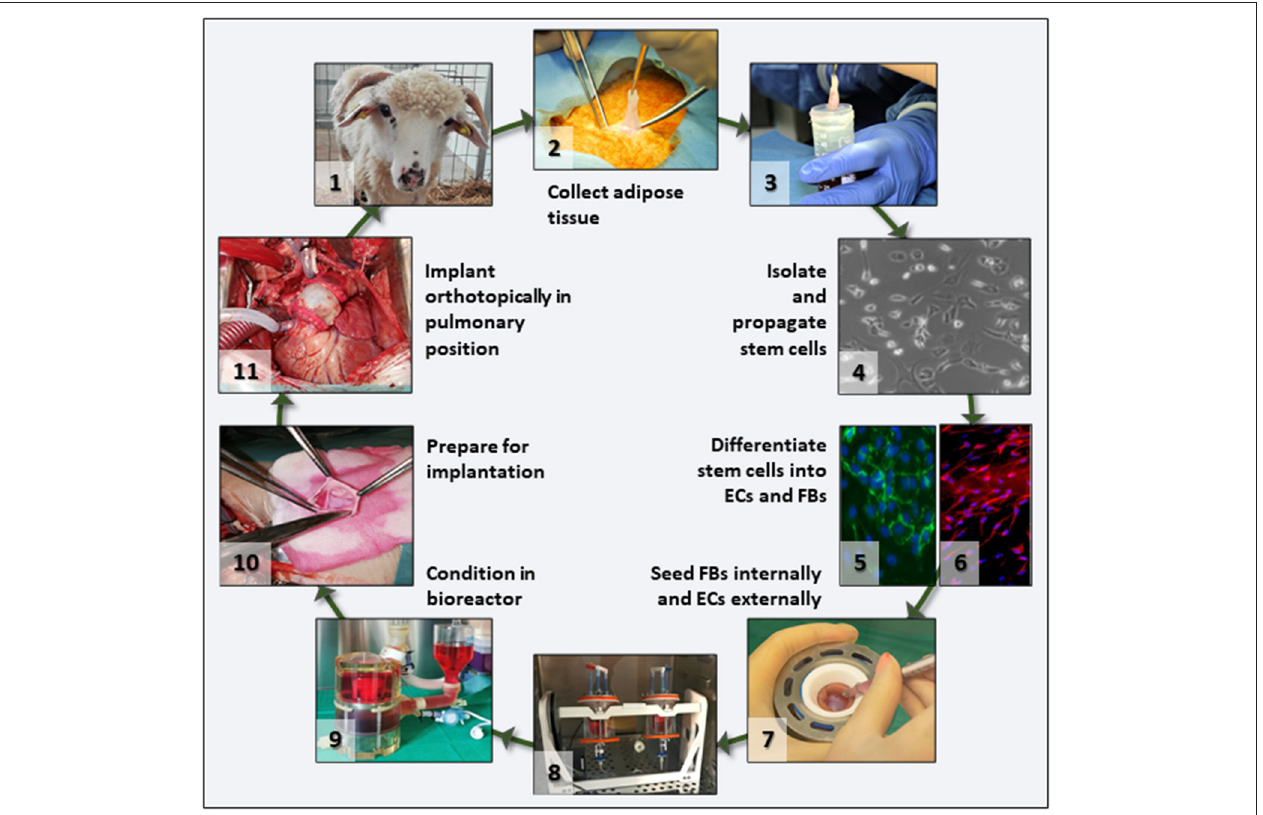
FIGURE 1 | Project overview. Flowchart depicting the main translational scenario steps that were tested in this study. After animal selection (1) , adipose tissue was collected under aseptic conditions (2) , the tissue transported to the lab in culture medium (3) , and stem cells isolated and propagated (4) . For differentiation, cells were split in two batches and separately differentiated into ECs (5) and FBs (6) . Then FBs and ECs were used to seed the acellular valve scaffolds (7) by injection and rotation (8) . Seeded valves were subjected to BR conditioning in sterile media (9) and transported to the operating theater where they were prepared (10) and then implanted orthotopically as autologous implants (11) in the same animal from which the stem cells had been